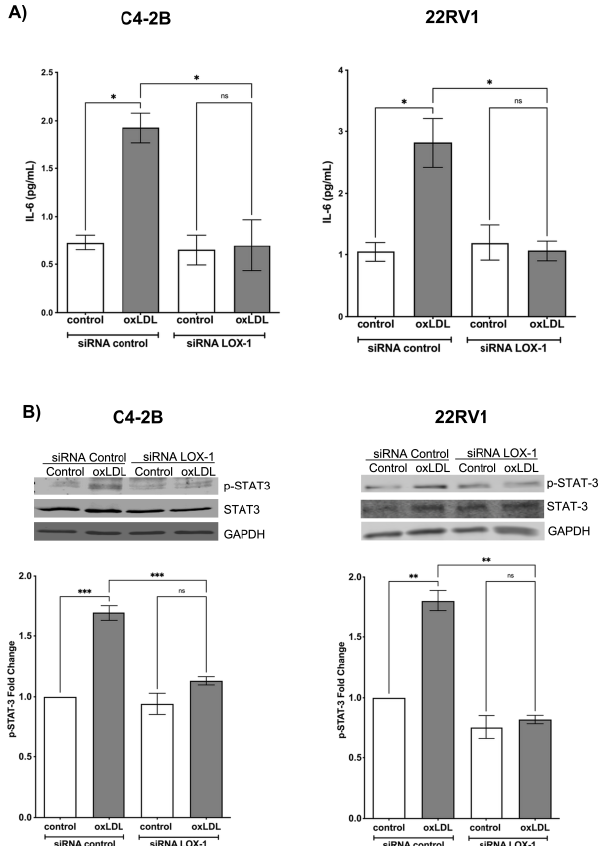
Figure 3. OxLDL/LOX-1 induces IL-6 secretion and STAT3 activation in CRPC cell models. ( A ) IL-6 ELISA assay from culture supernatants of C4-2B and 22Rv1 cells transfected with siRNA against LOX-1 or control and treated with 50 µ g/mL oxLDLs for 24 h. ( B ) OxLDLs/LOX-1 induce the activation of STAT3 in CRPC cell models. Western blot analysis of p-STAT3 in protein extracts of C4-2B and 22Rv1 cells transfected with siRNA against LOX-1 or siRNA control treated with 50 µ g/mL oxLDLs for 24 h. The data represent the means ± S.D. of three independent experiments analyzed by one-way analysis of variance and Dunnett’s post-test (*** p ≤ 0.001, ** p ≤ 0.01, * p ≤ 0.05, ns: non-significant statistical